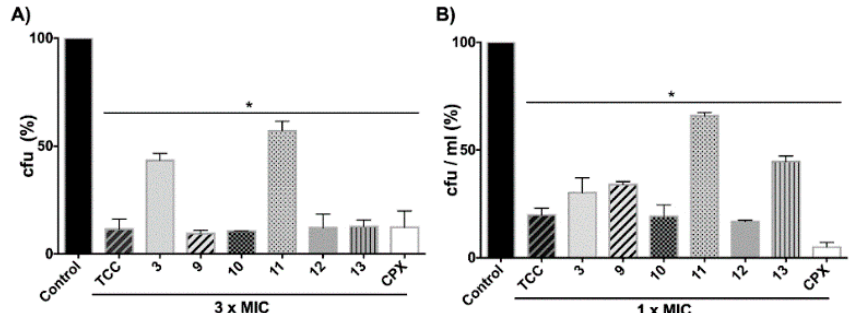
Figure 4. ( A ) Antibacterial effect of compounds on disinfection of contaminated surfaces by S. aureus and ( B ) on biofilms growing on catheters. * indicates statistically significant difference to the control (untreated) experiment ( p -value < 0.05 in pairwise t -test calculated with GraphPad 6.0). CPX was used as a control in all antimicrobial experiments, with a MIC 50 of 0.5 µ g/mL against all the bacteria pathogens tested. cfu, colony-forming unit.